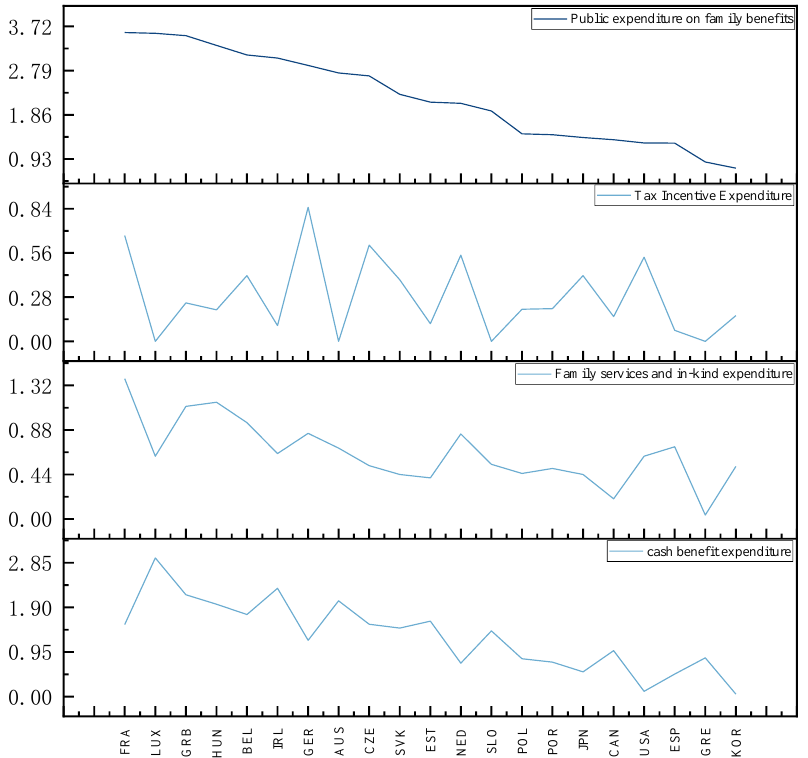
Figure 7. Average expenditure on total family welfare and average expenditure on three items in the selected OECD countries, 2001 – 2015.